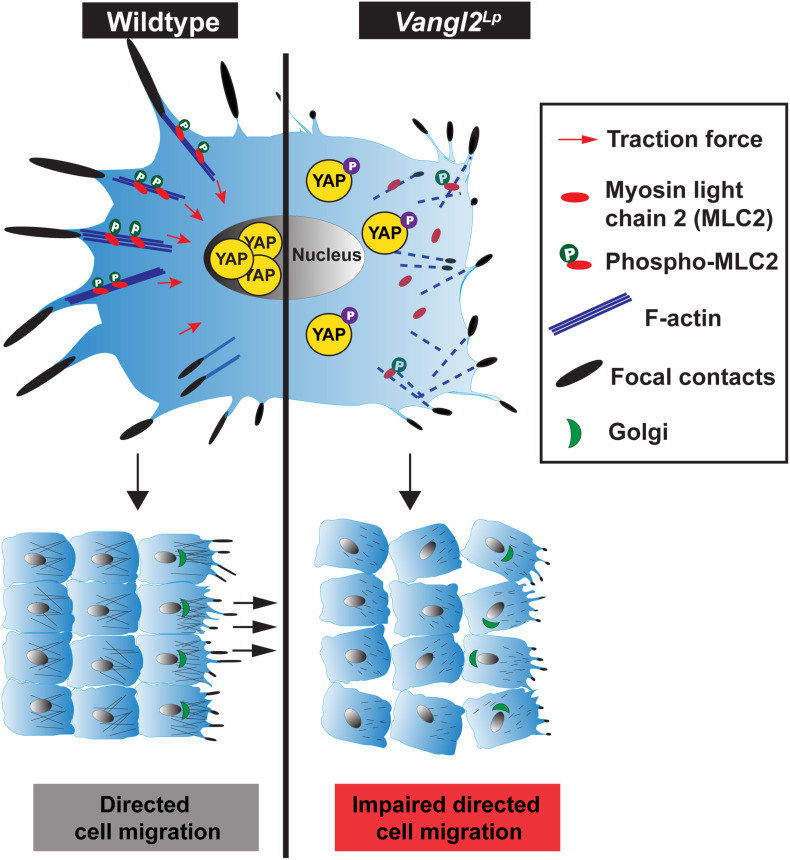
Comparison of cellular mechanics in wildtype and Vangl2Lp cells. (Left) In a normal cell, VANGL2 regulates the activation of myosin light chain 2 (MLC2) and F-actin and induces intracellular contractility. This gives rise to the generation of cellular traction force (red arrows) and promotes the formation of focal adhesion complexes. High mechanical cues within a cell then activate YAP signaling, rendering the translocation of YAP to the nucleus, leading to the transcriptional induction of YAP target genes. The optimal coordination of focal complexes, actomyosin contractile activity at the rear and pushing force at the front, as well as VANGL2-regulated cell polarity enables directed cell migration. (Right) In a Vangl2Lp cell, VANGL2 dysfunction leads to highly disrupted actin cytoskeleton, aberrant focal complex formation, and inhibition of MLC2 activation. This causes defective actomyosin-mediated contractility, which hampers traction force generation. Attenuated mechanosignaling within the cell inhibits activation of mechanosensitive protein YAP. YAP is phosphorylated, rendering its sequestration in the cytoplasm, thereby causing the transcriptional suppression of YAP target genes. Perturbation of traction force generation, aberrant focal contact formation, the lack of pushing force caused by highly disrupted actin cytoskeleton, and defective VANGL2-regulated cell polarity impede directed cell migration.